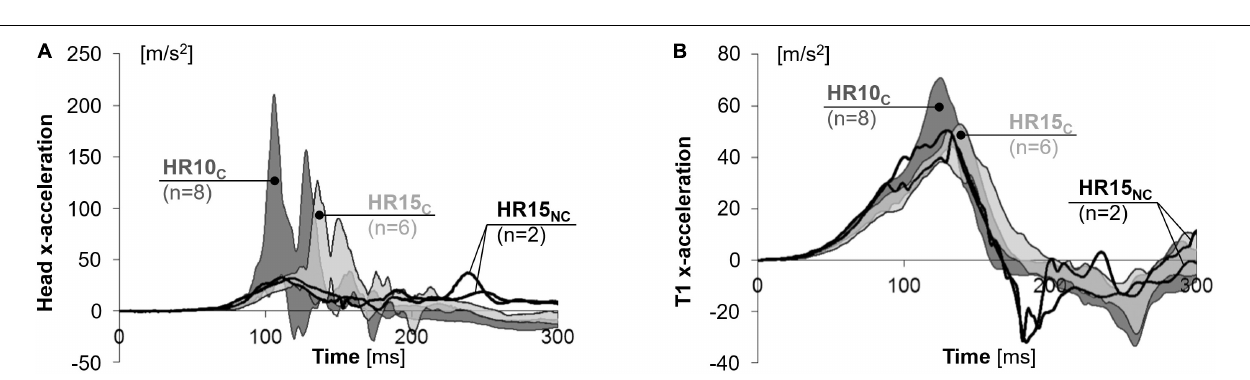
FIGURE 5 | Angular displacement of the (A) head, (B) T1, and (C) head relative to T1 for near 50th percentile female volunteers.